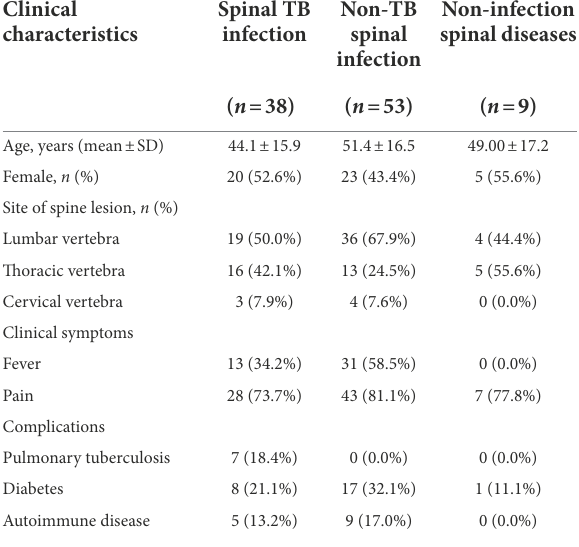
TABLE 1 Clinical characteristics of the studied patients. Clinical